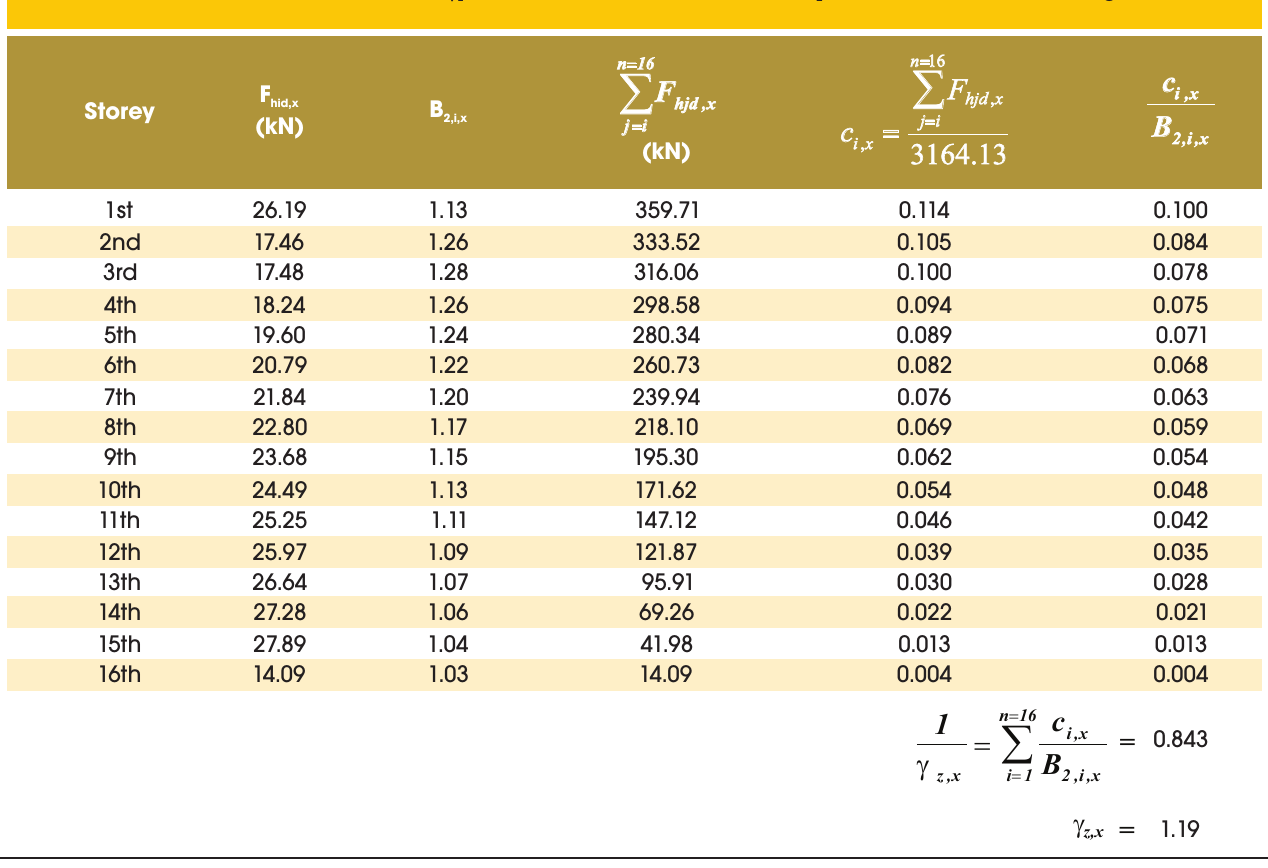
Table 4 – Calculation of the  coefficient, from the values of B , in direction X, for building I